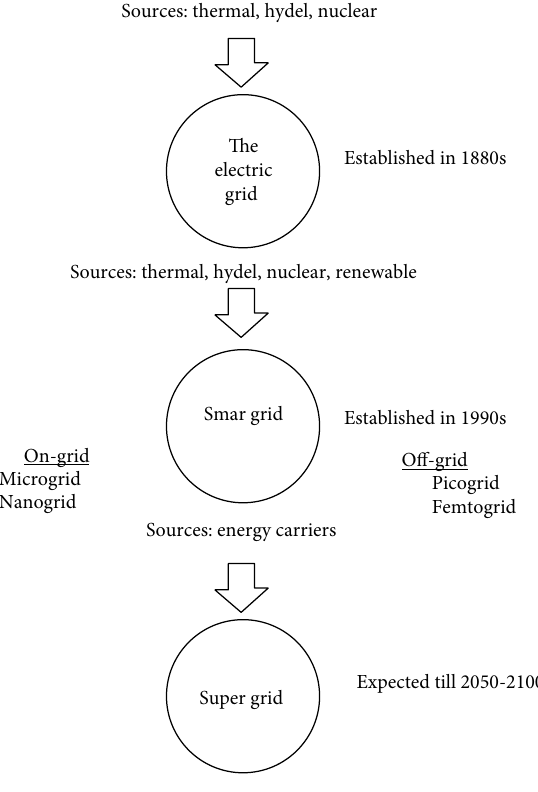
Figure 1: Chart explaining various grids interlinked or